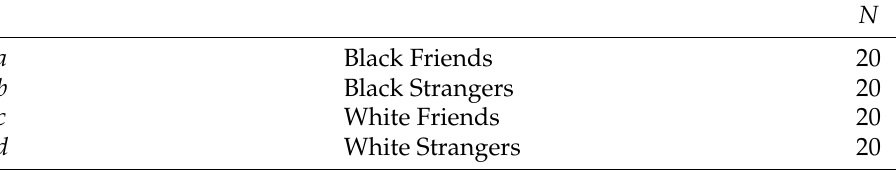
Table 1: Experiment 1